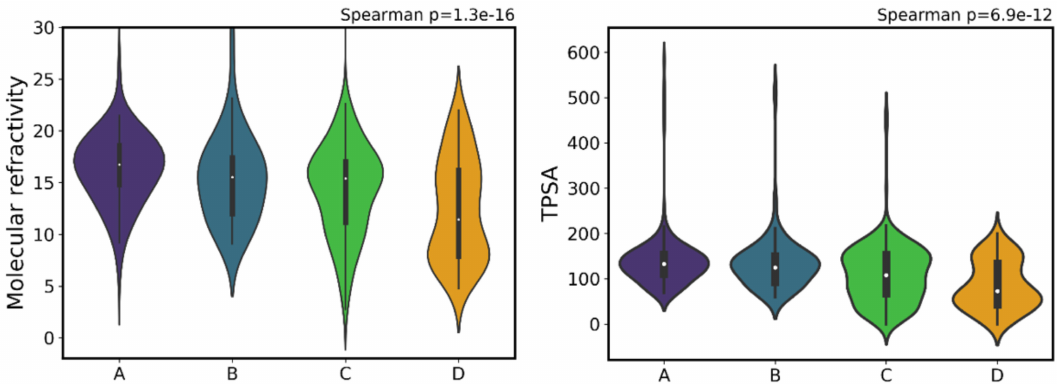
Figure 11. Distribution of molecular refractivity (MR) (left) and topological polar surface area (TPSA) (right) across the di ff erent activity